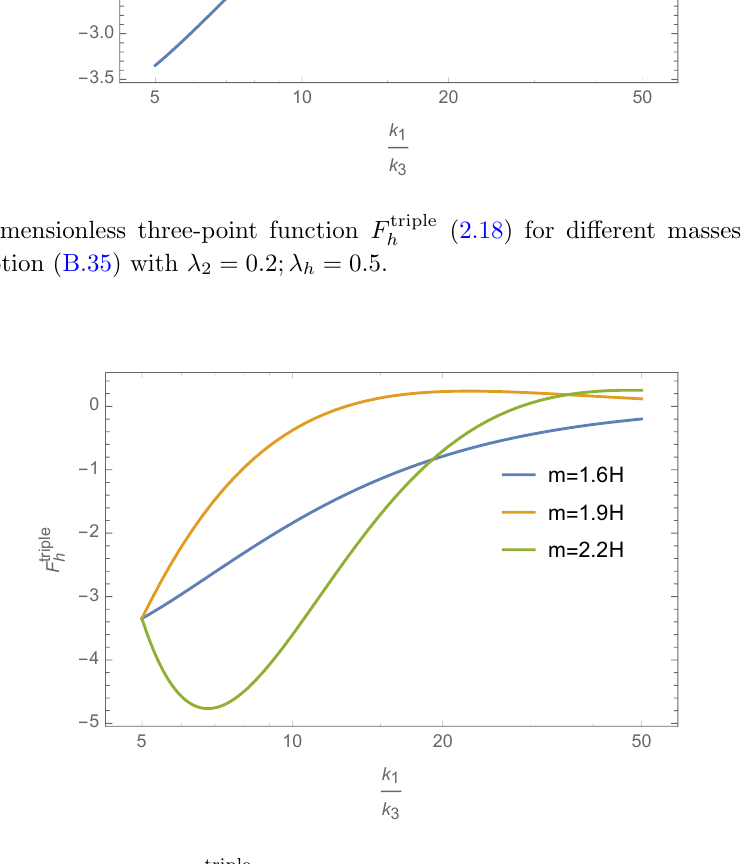
Figure 12 . Shape sensitivity of F triple to m h . We have chosen three plausible sets of parameters h for which F triple agree at the (cid:12)ducial ratio k 1 = 5. This illustrates our ability to discriminate among h k 3 di(cid:11)erent masses.